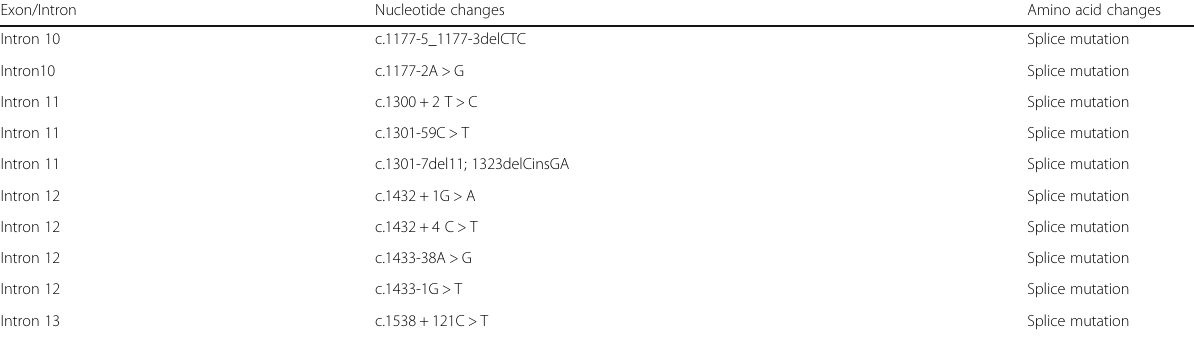
Table 1 Germline mutations in Birt-Hogg-Dubé syndrome (Continued)